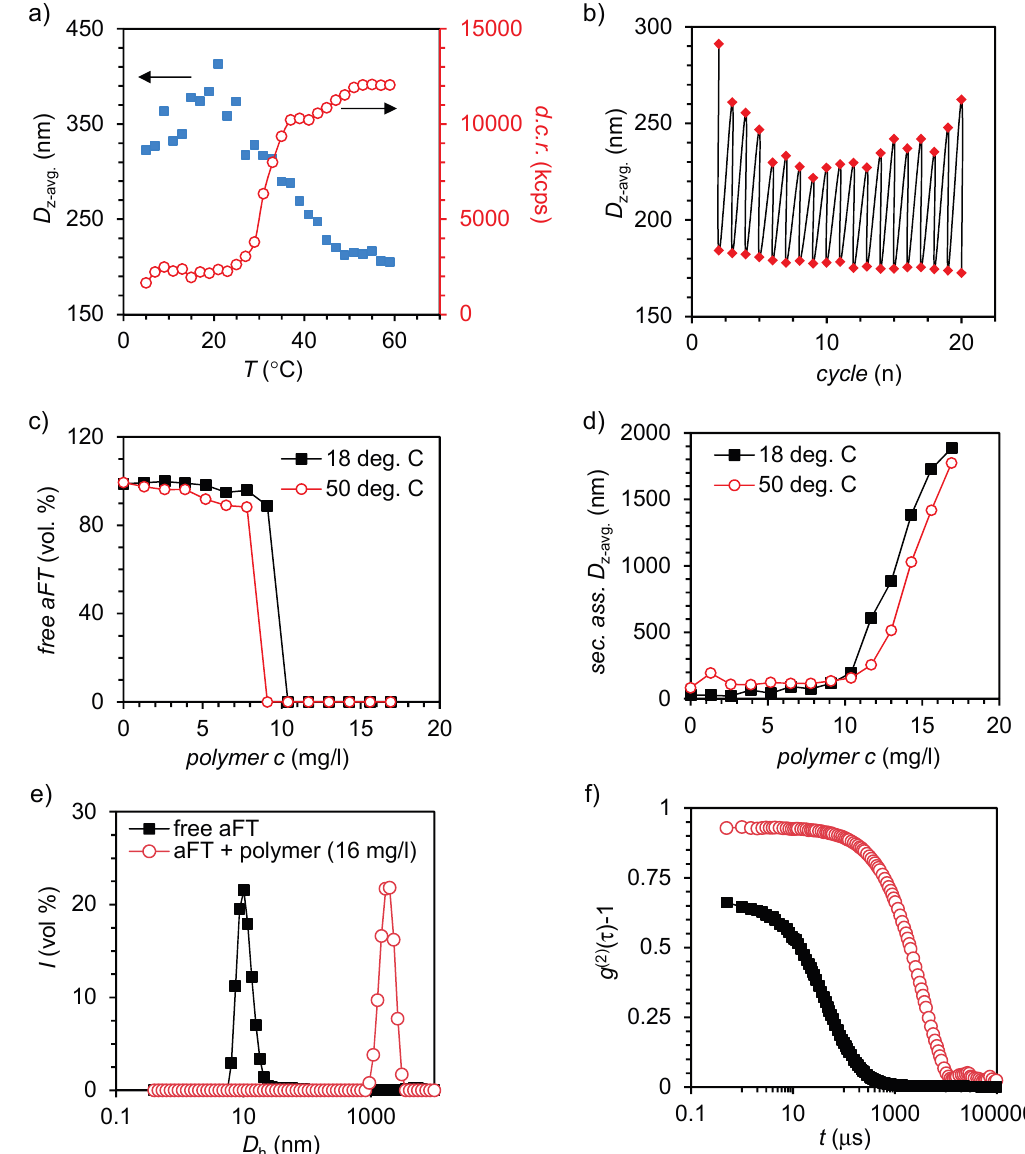
Figure 2. ( a ) Z-average diameter and derived count rate for 4 (150 mg/L) as a function of temperature; ( b ) Reversible thermal switching of size by cycling temperature between 18 and 50 °C; ( c , d ) Titration of aFT with 4 below (18 °C) and above (50 °C) T cp followed by the scattering from free aFT ( c ) and formation of large secondary assemblies ( d , e ). Volume-average size-distribution measured from free aFT (100 mg/L) and aFT- 4 (16 mg/L) complexes; and ( f ) the corresponding second-order autocorrelation